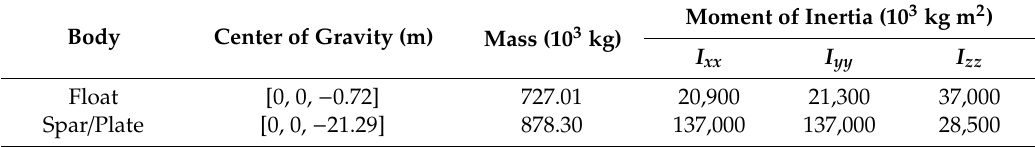
Table 2. General properties of the two-body floating-point absorber WEC